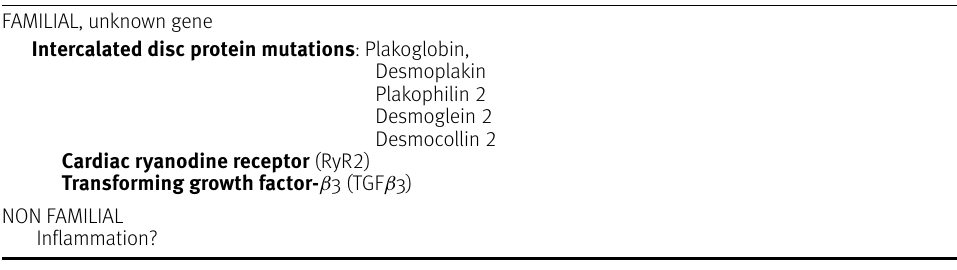
Table 4. Arrhythmogenic right ventricular cardiomyopathy.